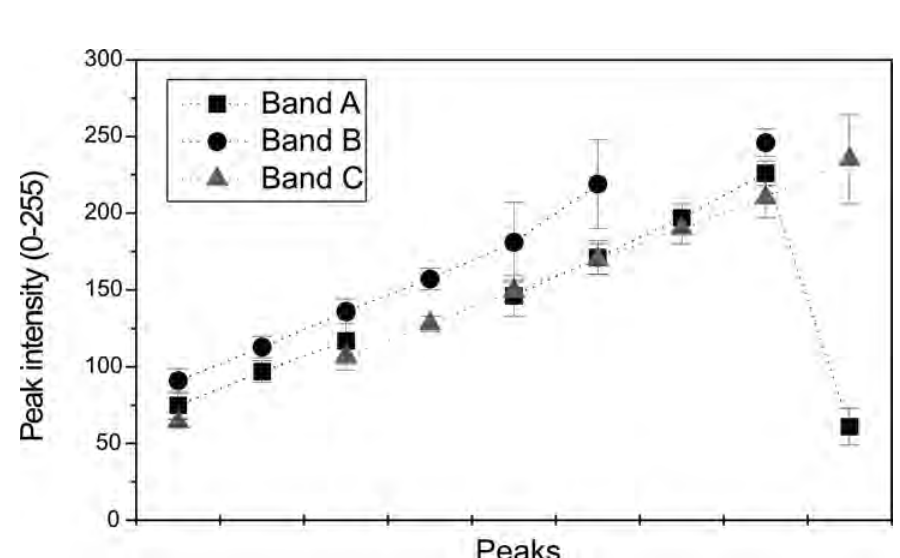
Fig. 9. Intensity peaks recognized considering three vertical bands 5 m width in the B-zone.